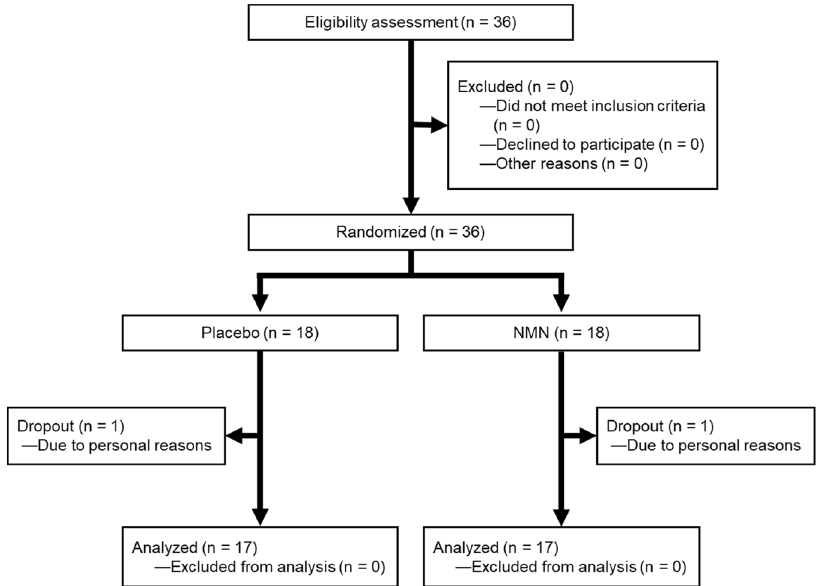
Figure 1. Clinical trial flowchart.